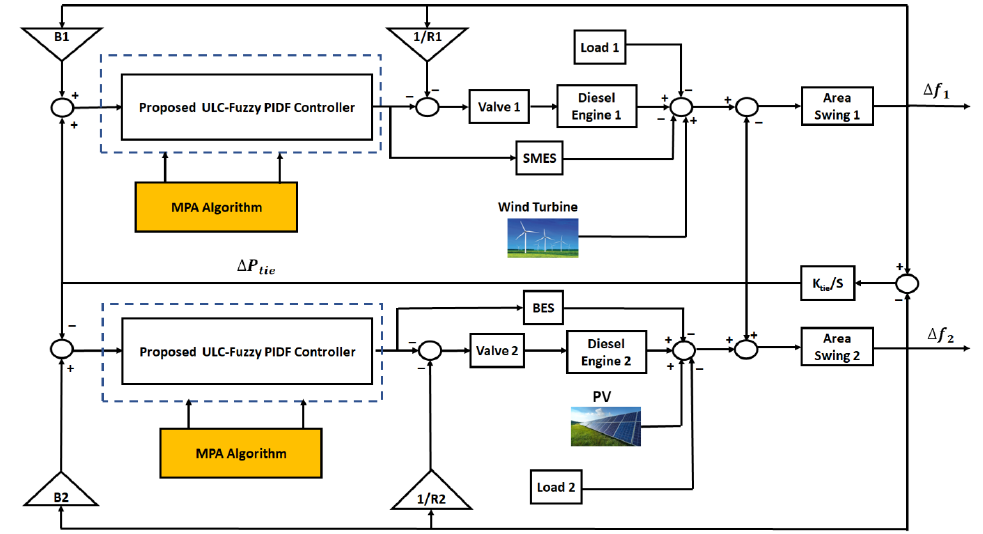
Figure 1. The hybrid microgrid system’s block diagram. Table 1. Values for model parameters [43].